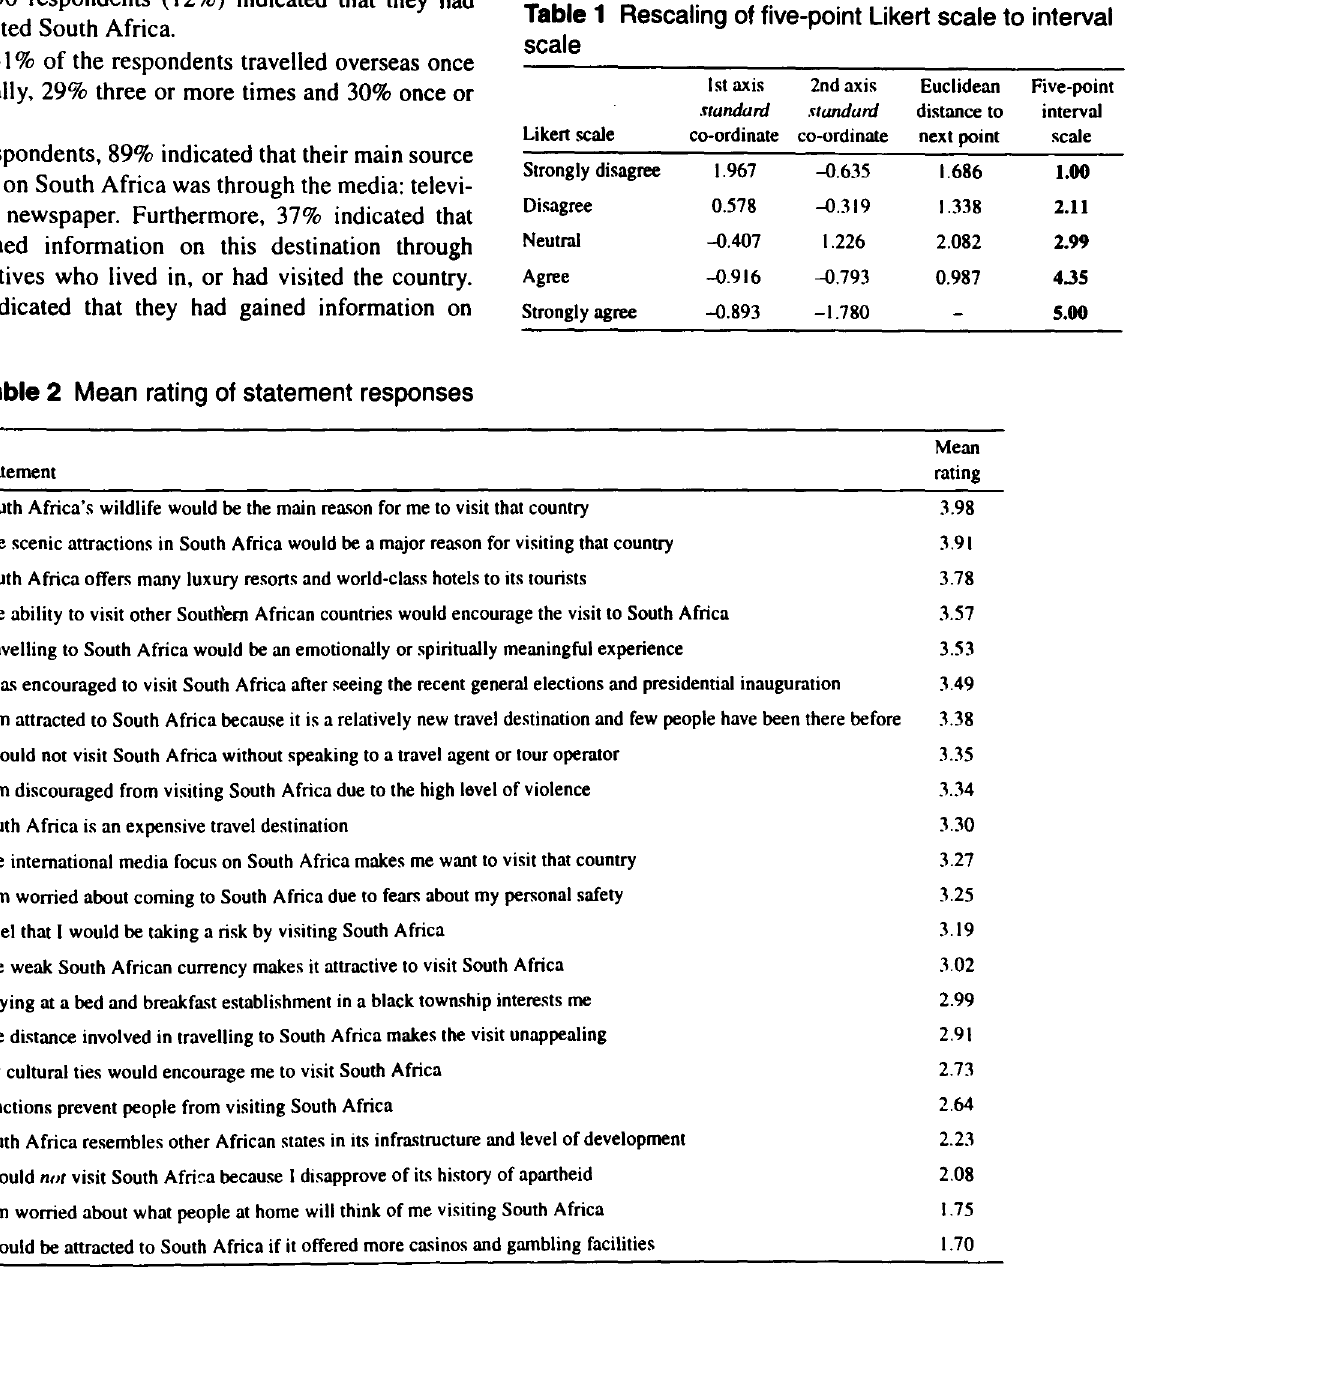
Table 1 Rescaling of five-point Likert scale to interval